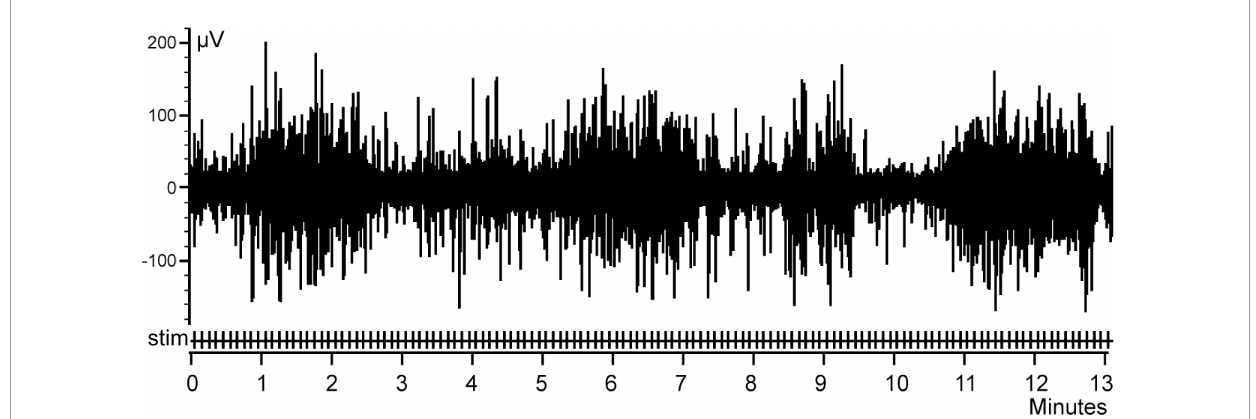
FIGURE1 An example of a rabbit electroencephalogram (EEG) activity. Stimulations of the abdominal viscera are denoted as Stim.